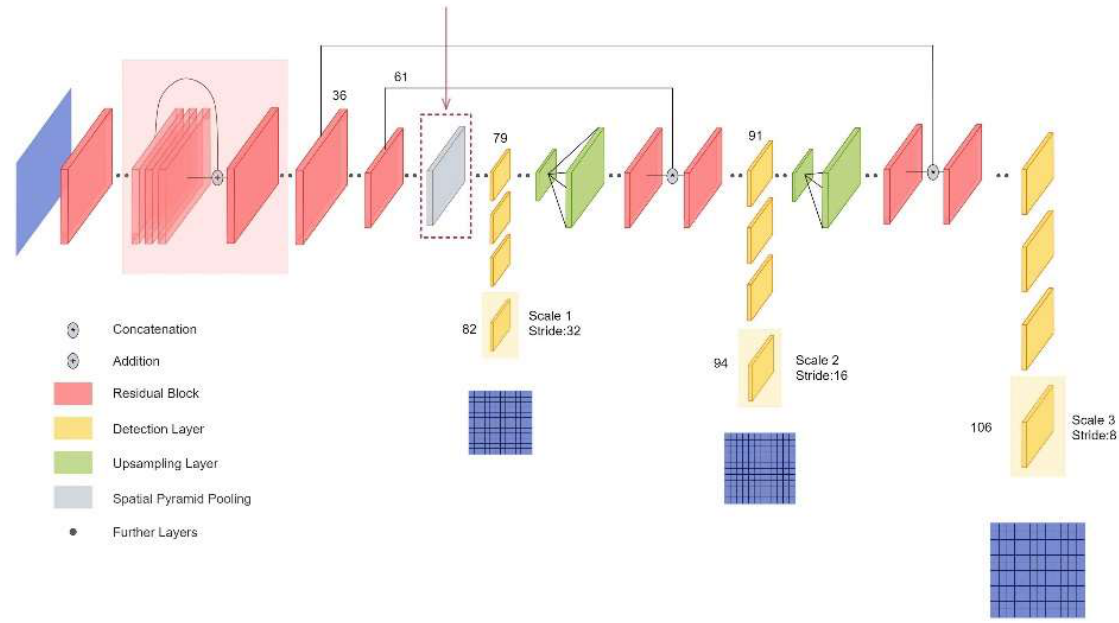
Figure 7. The model of YOLO V3 + SPP. Algorithm 6 : YOLO V3 + SPP Algorithm